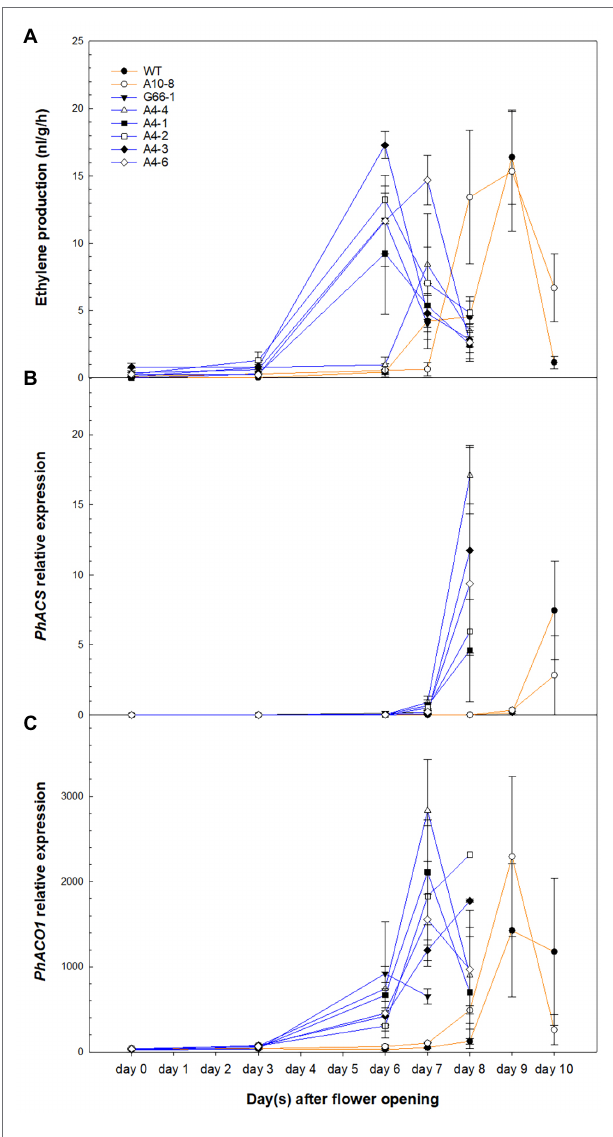
FIGURE 5 | Ethylene production and ethylene biosynthesis gene expression in the corollas of Petunia × hybrida ‘Mitchell Diploid’ wild-type plant (WT), non-mutated regenerated line A10-8, and PhATG6 -KO lines from flower opening to senescence. (A) Ethylene production ( n = 6). (B) Relative expression of 1-Aminocyclopropane 1-Carboxylate Synthase ( PhACS ; n = 2). (C) Relative expression of 1-Aminocyclopropane 1-Carboxylate Oxidase 1 ( PhACO1 ; n = 2). Orange lines represent the results of controls (WT and line A10-8), and blue lines represent the results of the PhATG6 -KO lines. The relative expression was calculated based on the expression of reference genes PhActin and PhSAND . Data represent the means of the measurements ± standard